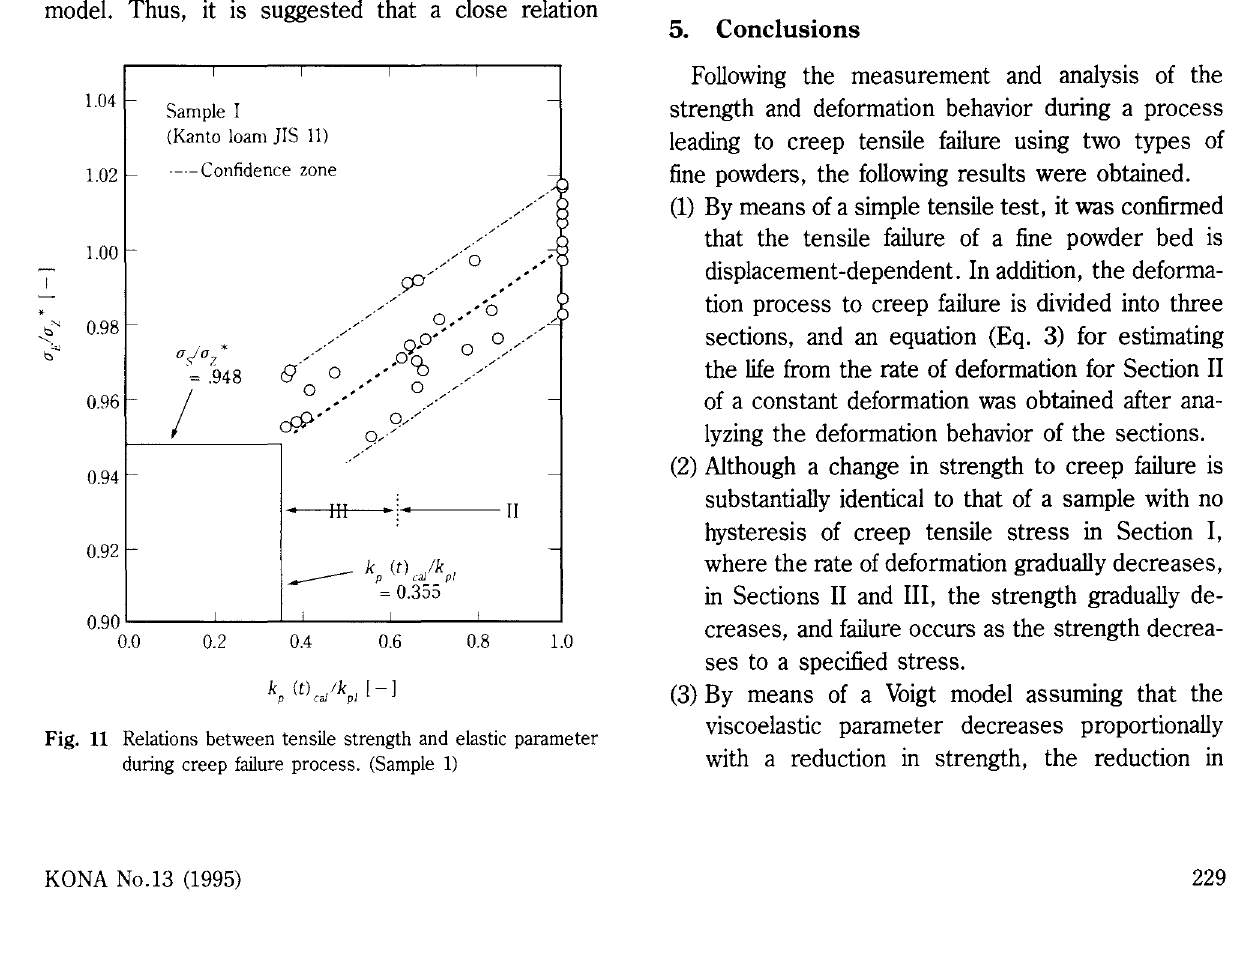
KONA No.l3 (1995)